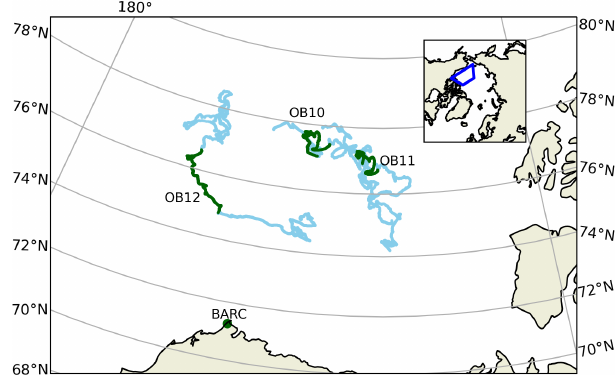
Figure 2. Locations of MAX-DOAS BrO observations used in this work. Blue lines show the drift tracks of O-Buoys, with green show- ing the locations with valid BrO measurements in spring 2015. Lo- cation of Barrow Arctic Research Center (BARC) in Utqia˙gvik in- dicated by green dots. True color MODIS imagery on 1 April 2015 shows typical sea ice coverage (NASA, 2015). The inset map shows the location of the map grid within the Northern